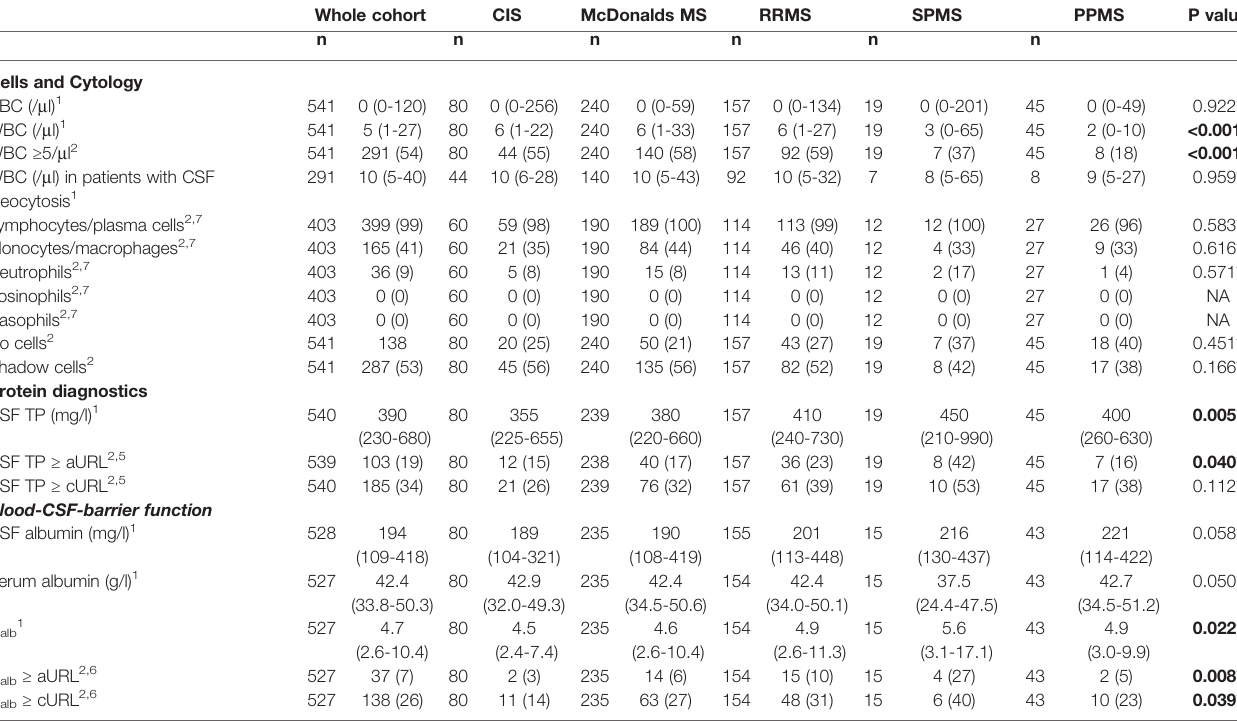
TABLE 1A | Cerebrospinal fl uid fi ndings in multiple sclerosis and according to different disease courses: Cells and blood-CSF-barrier. Whole cohort CIS